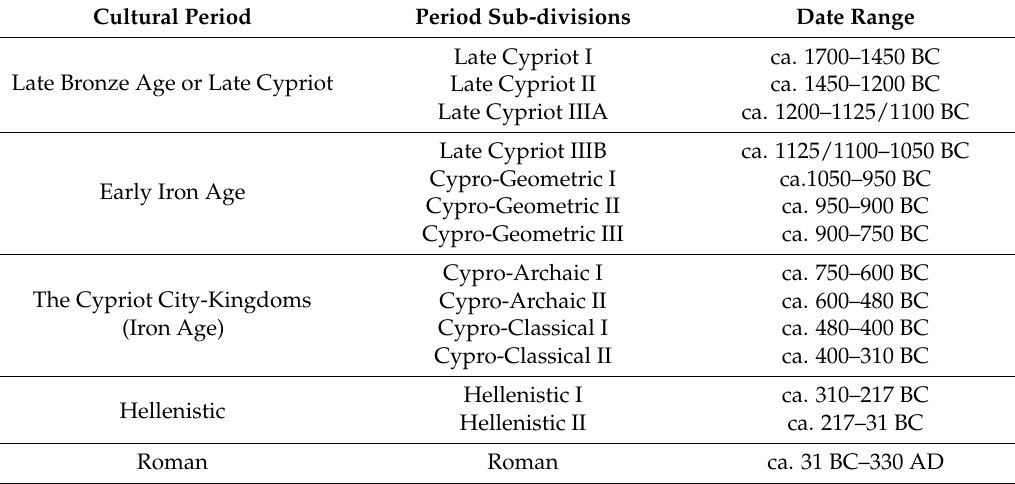
Figure 1. Iron Age urban centres and distribution of definite and possible Cypro-Archaic sanctuary sites; Archaeological data from Unlocking Sacred Landscapes of Cyprus (UnSaLa-CY) database; Digital data courtesy of the Geological Survey Department, Cyprus (by Vasilis Trigas). Table 1. Chronology of Cultural Periods in Cyprus (after [4] (p. 533, table